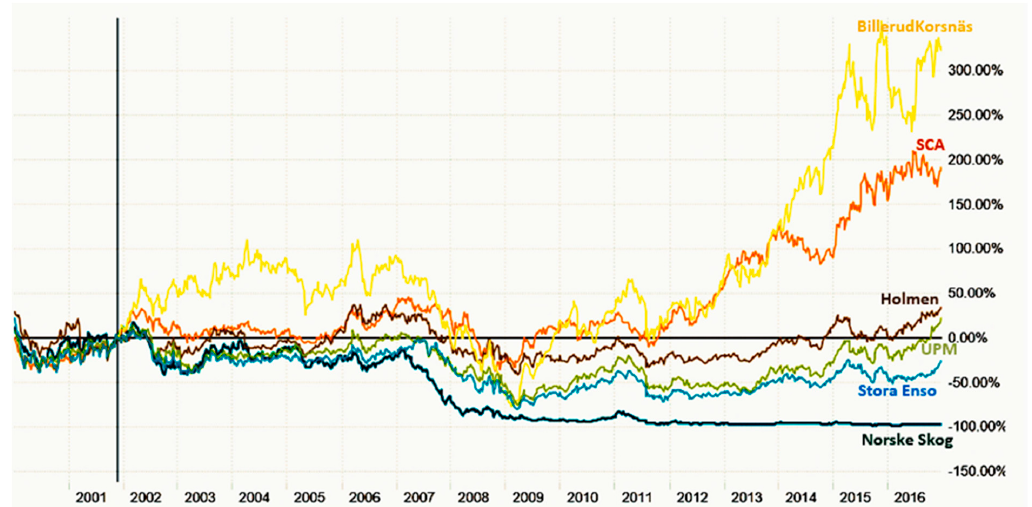
Figure 7. Share price development of six Nordic companies in the forestry, paper & packaging industry, 2000–2016. Source: [14].